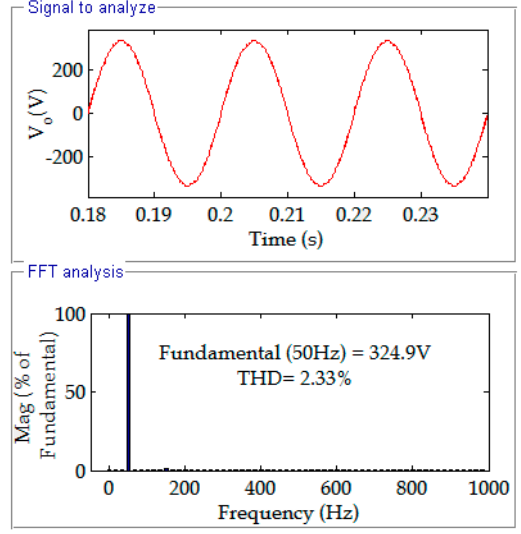
Figure 3. Harmonic spectra of 127 − level MLI.